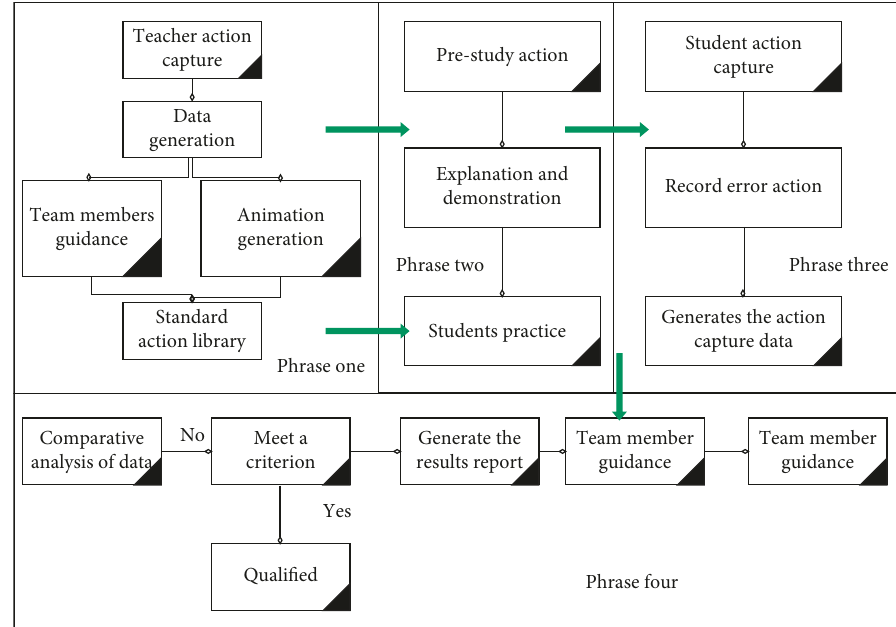
Figure 12: Sports dance movement process based on motion capture.